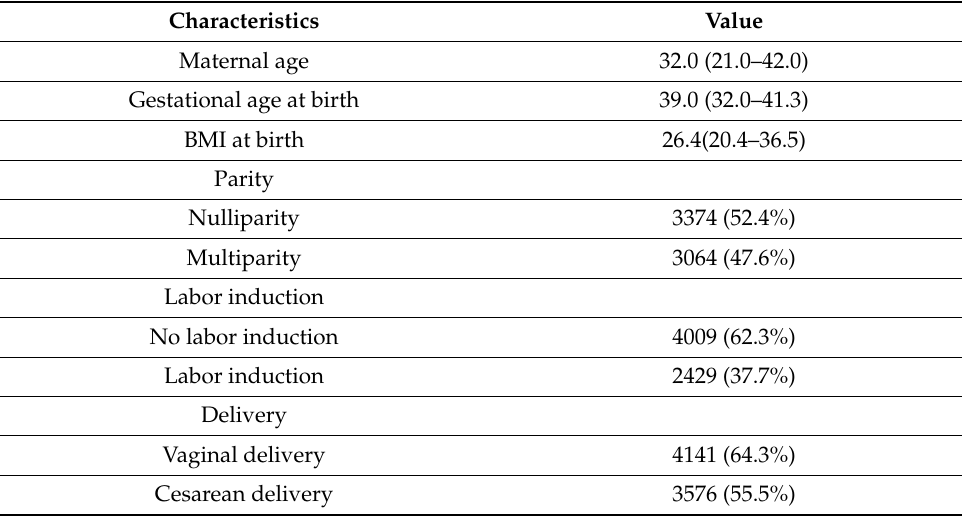
Table 1. Clinical characteristics of the study population .